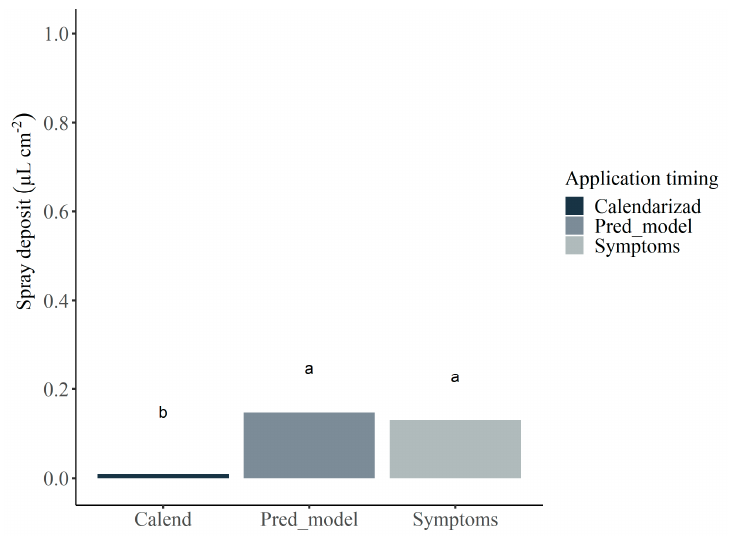
Figure 10. Mean deposit values ( µ L cm − 2 ) that were collected in the upper region of the soybean canopy at different application timings in the second application of Field 2. The means followed by the same letter did not differ by the Tukey’s test at 5% probability ( p < 0.05).